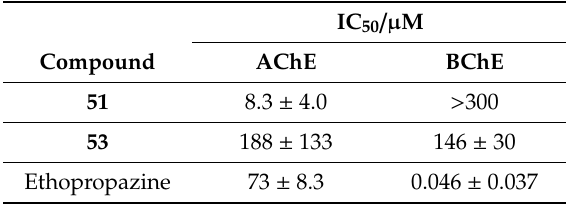
Figure 14. Partial 1 H NMR spectra of starting compound 49 and the acylation product 51 with the opened furan ring. Table 4. Inhibition of human AChE and BChE by acylated furo-benzobicyclo [3.2.1]octenes / octadienes expressed as IC 50 ±